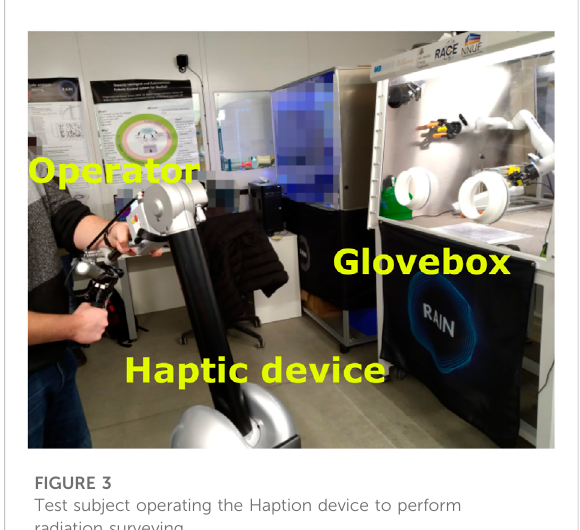
FIGURE 3 Test subject operating the Haption device to perform radiation